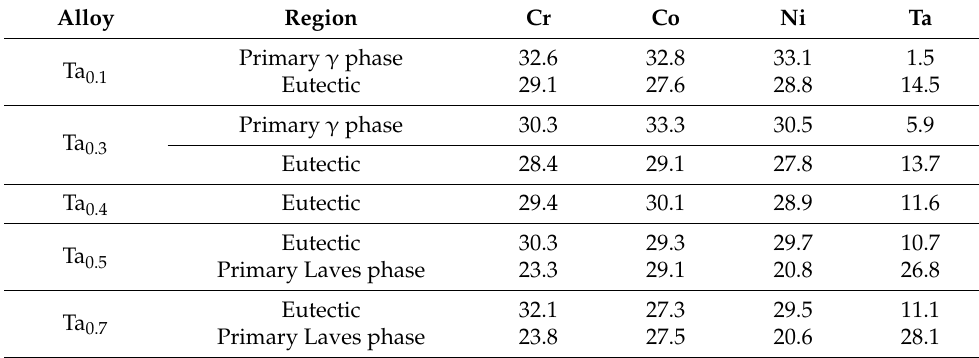
Table 1. Composition of characteristic regions in CrCoNiTa x alloys (in